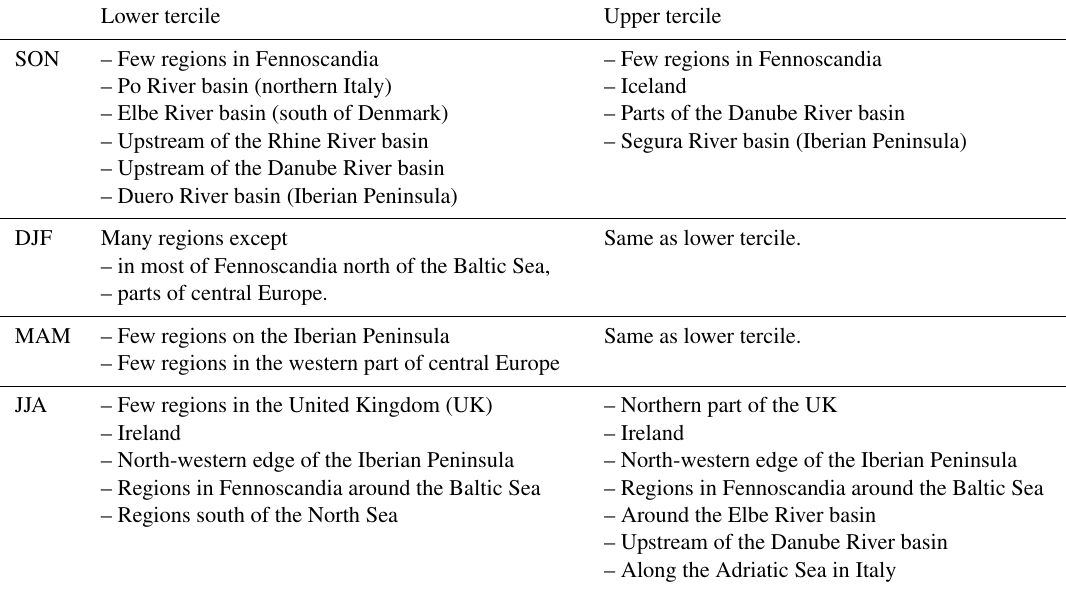
Table 1. Regions where the CM-SSF is more skilful than the ESP at predicting anomalously low (lower tercile; first column) or high (upper tercile; second column) streamflows for all four seasons (SON, DJF, MAM and JJA from the top to bottom rows). This is a summary of the information displayed in Fig.